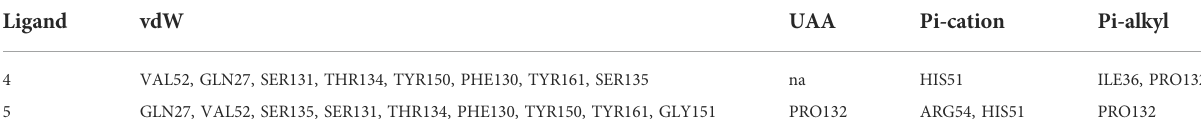
TABLE 3 The non-bonding type of interactions of compound 4 and compound 5 in the binding pocket of DENV2 NS2B-NS3 protease.